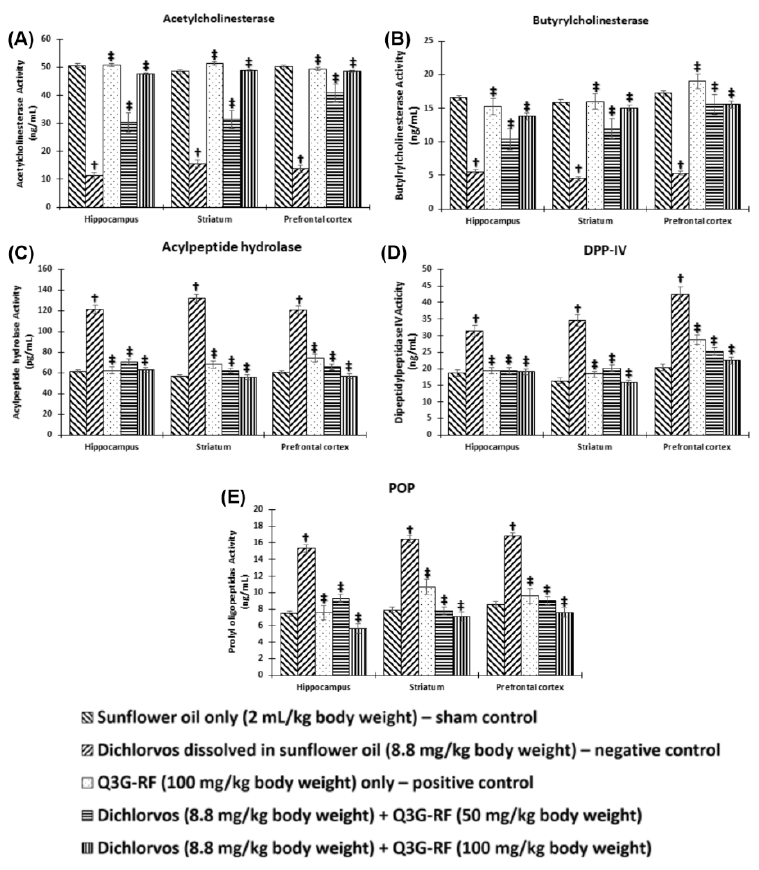
Figure 2. Capacity of Q3G-RF from S. mombin leaves to reverse the inhibition of cholinesterases and alteration in activities of brain enzymes exposed to DDVP. Activities of AChE ( A ), BuChE ( B ), APEH ( C ), DPP-IV ( D ) and POP ( E ) of Wistar rats treated with sunflower oil, DDVP alone, Q3G-RF alone, and DDVP + Q3G-RF (50 and 100 mg/kg). Values are expressed as mean ± standard error of mean ( n = 10). Significant differences from the positive control group are indicated by † and from DDVP alone by ‡ , ( p < 0.05). DDVP, Dichlorvos; Q3G-RF, Quercetin-3-O- β -D-glucopyranoside-rich fraction from Spondias mombin .